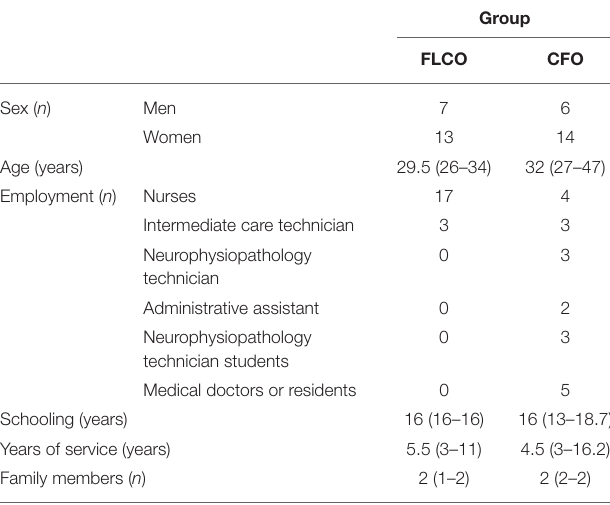
TABLE 1 | Description of the